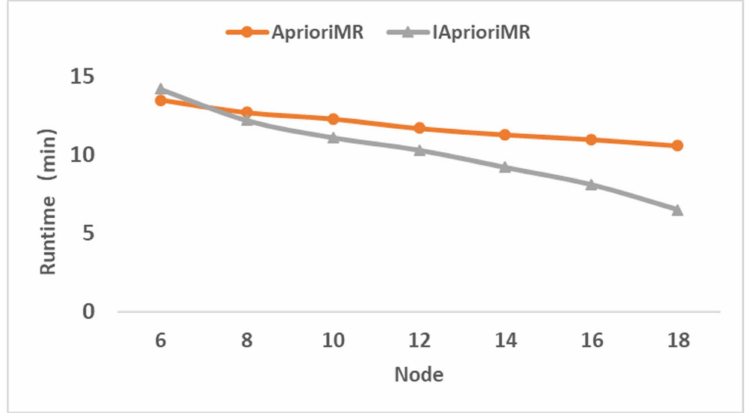
Figure 3. Runtime of nodes from 8 to 20 for di ff erent algorithms in 128,000 Figure 2. Runtime of different algorithms on the dataset and a number of instances that varies from 2000 to 1,024,000.